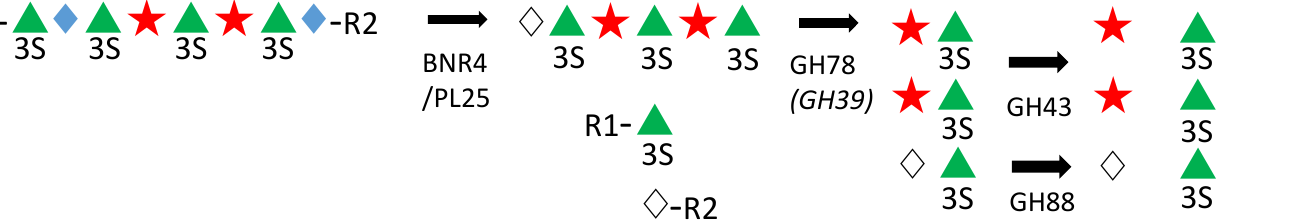
Figure 8. Model of the ulvan degradation pathway in Echinicola sp. 20G as suggested by the genomic and biochemical analyses in this study. This figure is modified based on Reisky et al., 2019 [4]. ▲ , L -Rhamnose; ♦ , D -Glucuronic acid or L -Iduronic acid; ♢ , unsaturated uronic acid; ★ , D -Xylose. Italic, not found in this study.